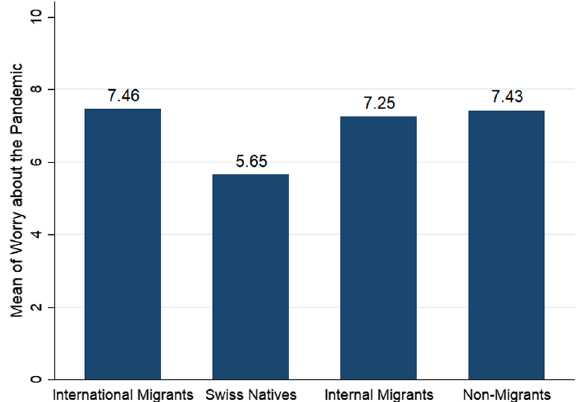
Fig. 1 Comparison of mean of worry about the pandemic between survey